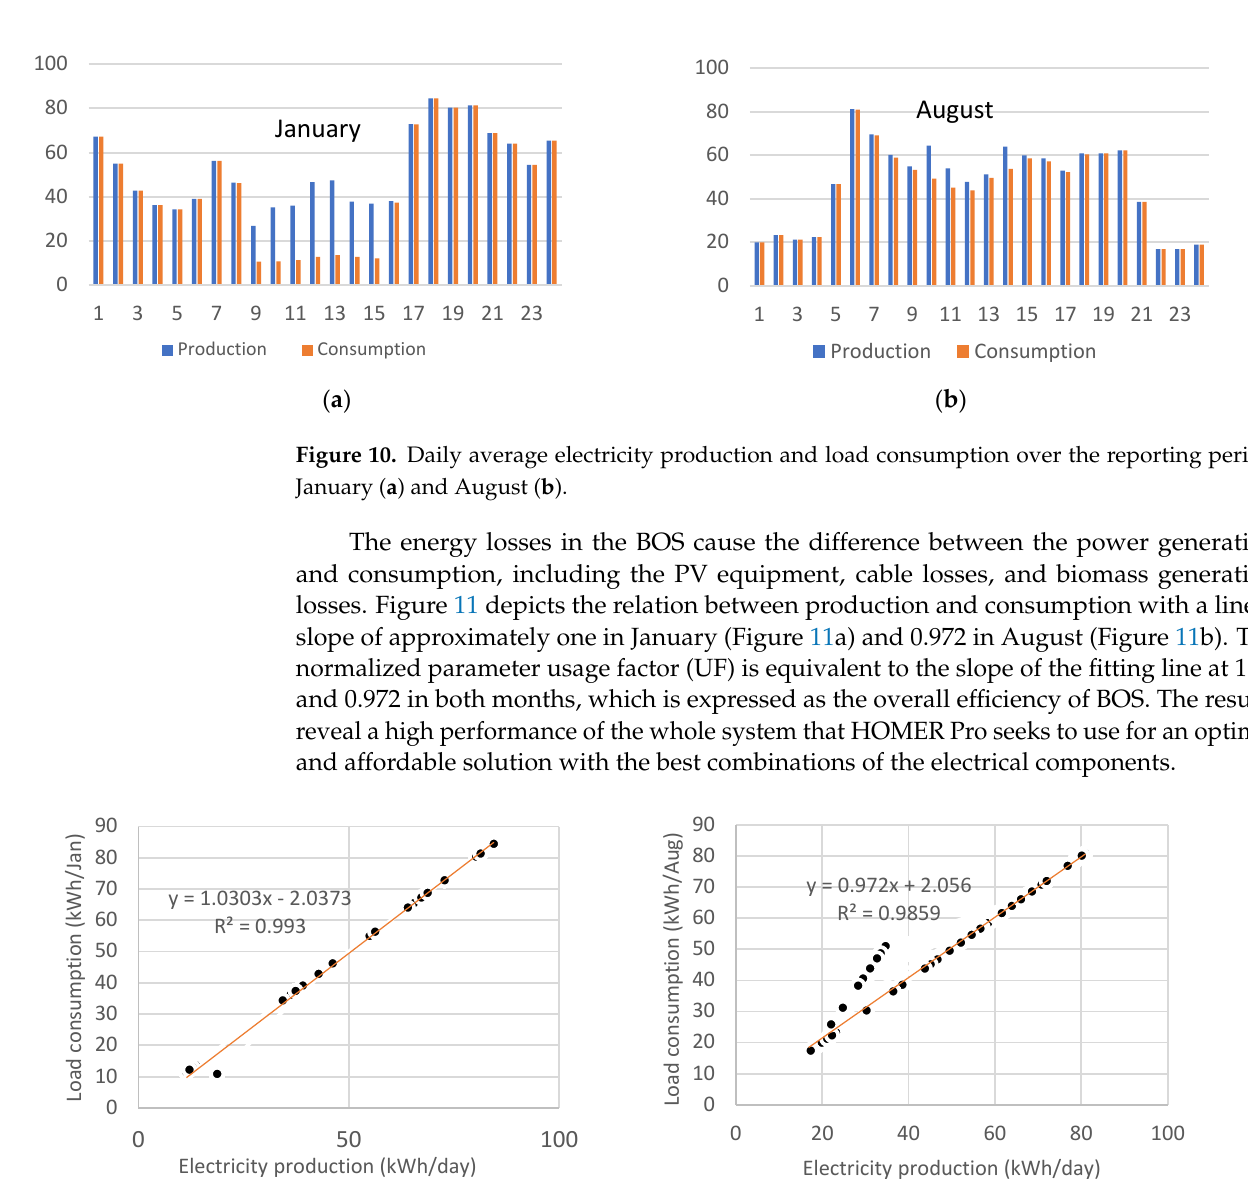
Figure 11. The monthly average power consumption and production correlation, January ( a ) and August ( b